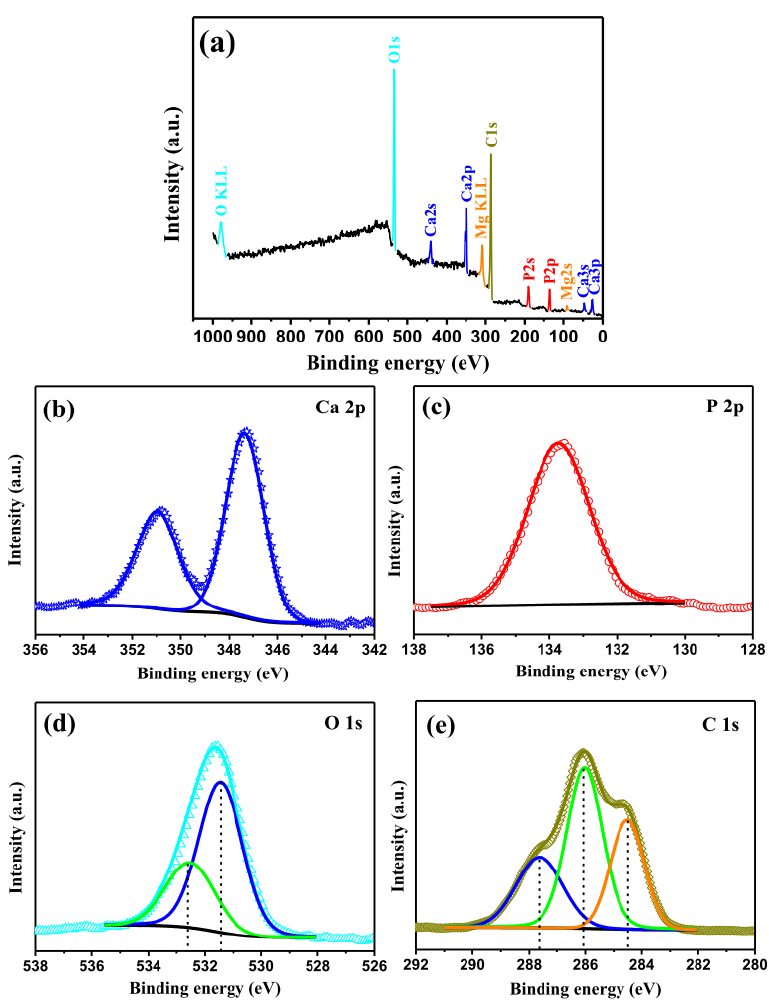
Figure 13. ( a ) XPS survey spectrum and the core level spectra of: ( b ) Ca 2p; ( c ) P 2p; ( d ) O 1s; and ( e ) C 1 s taken from the biomimetic apatite layer on the surface of the β‐ Ta coating after immersion in Hank’s solution for seven days.